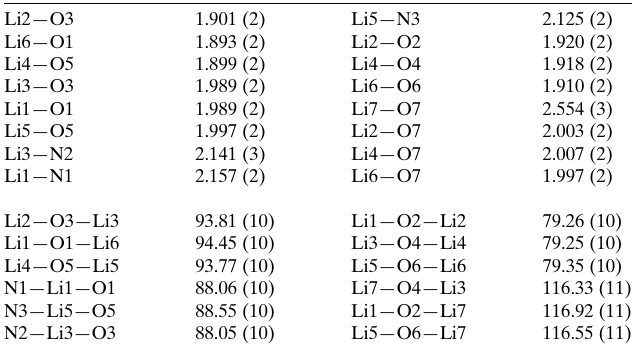
Table 1 Selected geometric parameters (A˚ , (cid:4) ) for 1 .